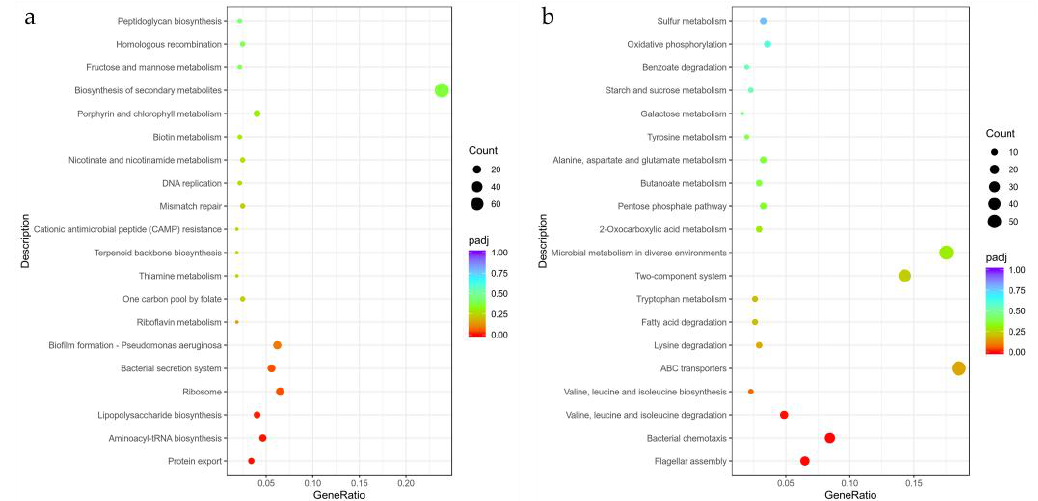
Figure 9. Kyoto Encyclopedia of Genes and Genomes (KEGG) enrichment analysis: ( a ) up-regulated; ( b ) down-regulated.